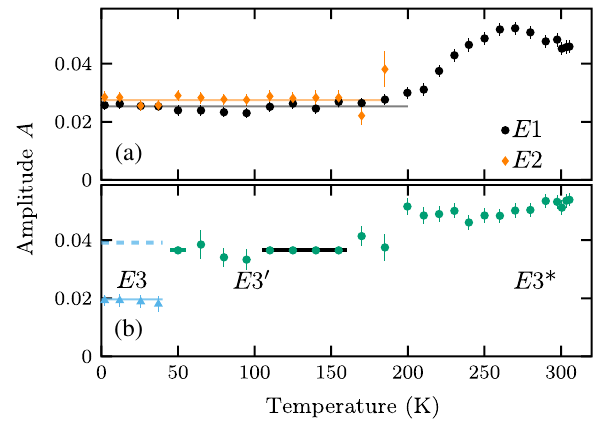
FIG. 11. Fit results for 4 T jj c spectra: amplitudes for (a) E 1 and E 2 , and (b) for E 3 , E 3 0 , and E 3 (cid:3) . The black bar indicates that the value is fixed to 0.0365.